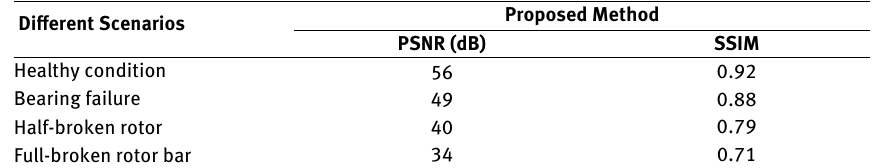
Table 4: PSNR and SSIM obtained for four different scenarios by the proposed method